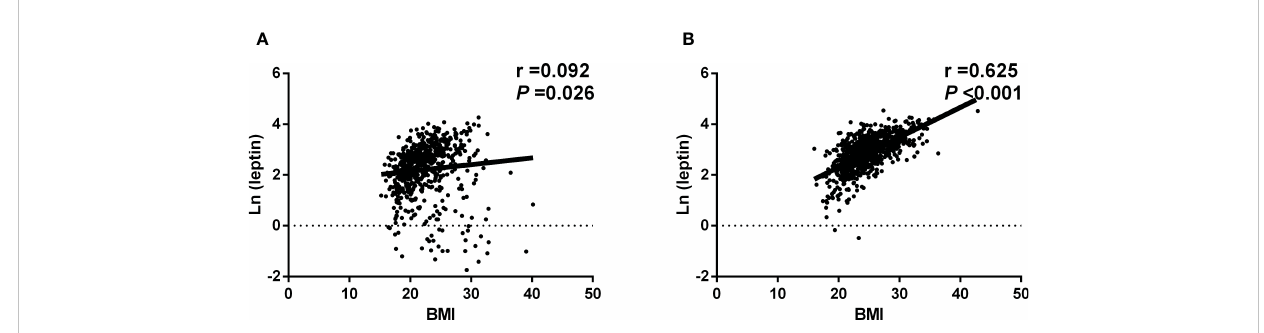
FIGURE 1 Scatter plot of BMI and Ln (leptin) (A) The native women living at high altitude. Pearson correlation analysis indicated that Ln (leptin) was mildly and positively correlated with BMI. (B) The native women living at low altitude. Pearson correlation analysis showed that Ln (leptin) was strongly and positively correlated with BMI.